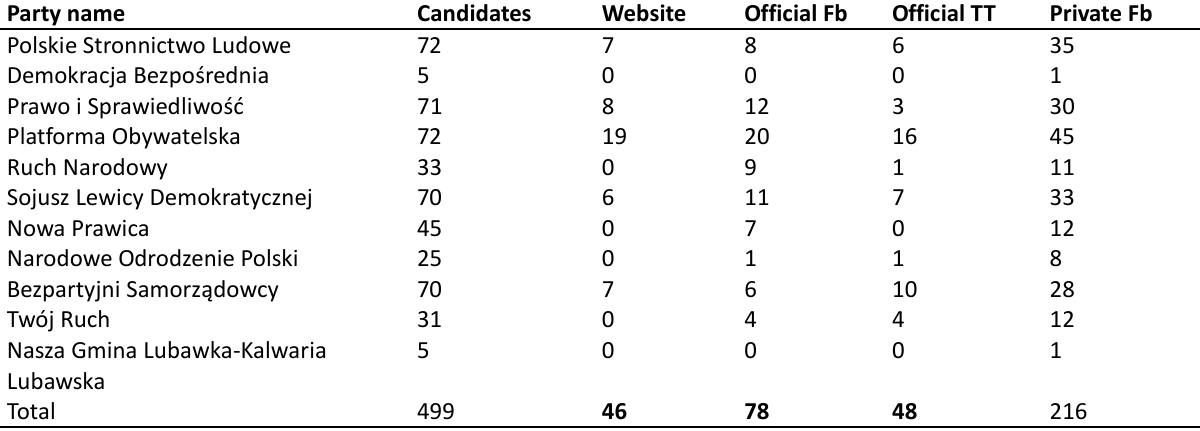
Table 2. Overall share of Internet